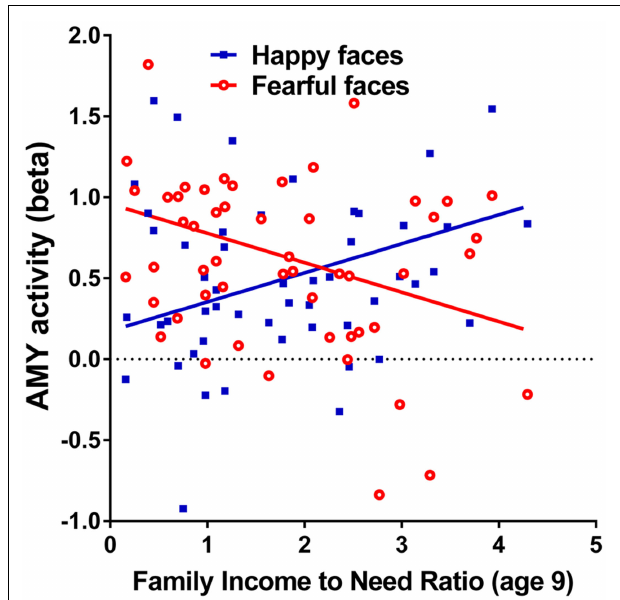
FIGURE 2 | Correlations of adult amygdala responses to fearful and happy faces with childhood family income . Relationship childhood income-to-needs ratio (on x axis), and amygdala reactivity (on y axis) to fearful faces – shapes (open circles) and happy faces – shapes (filled squares) expressed as parameter estimate of extracted from anatomical amygdala ROI ( y axis). Fearful faces R 2 = 0.106, P = 0.017; Happy faces R 2 = 0.095, P =